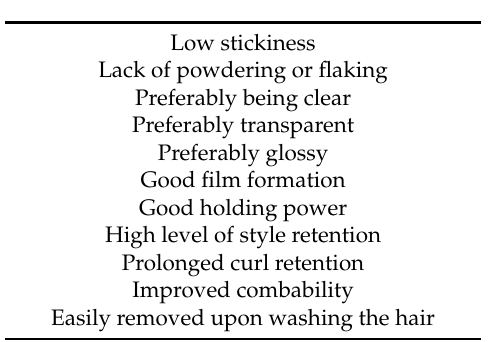
Table 4. Hair care products